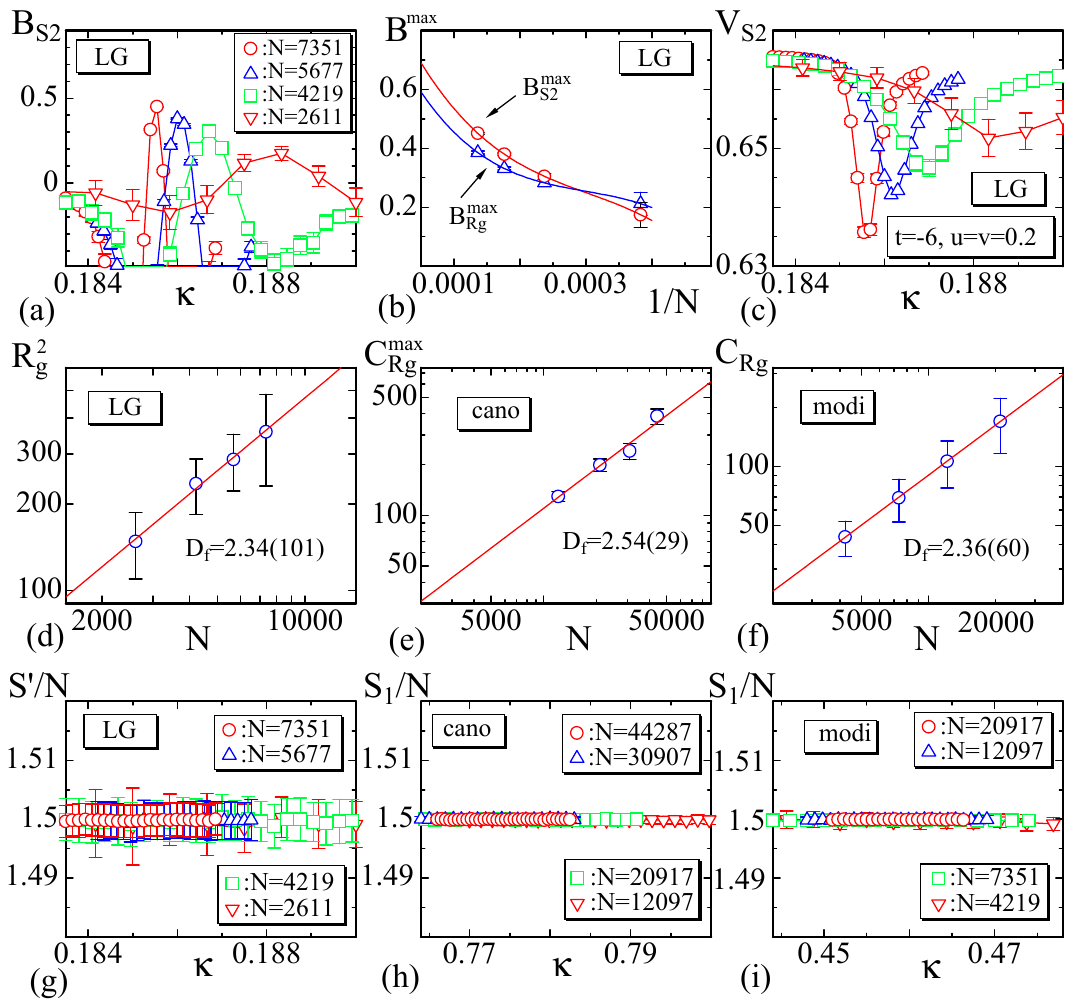
Figure 9. ( a ) The Binder quantity B S drawn by Mathematica command “Interpolation”, and ( c ) the Binder cumulant V S The log-log plot of R 2 g vs. N of ( d ) the LG model, ( e ) the canonical model, and ( f ) the